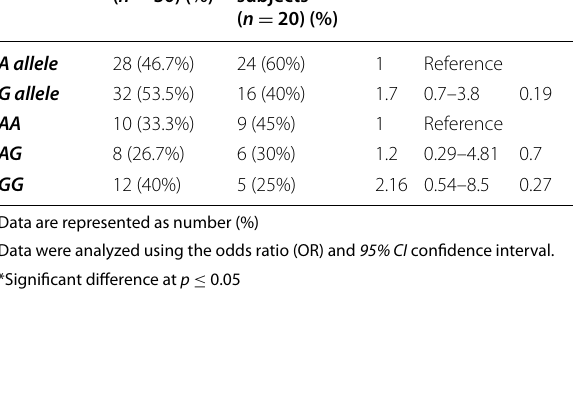
Table 3 Comparisons regarding the distribution frequencies of genotypes and alleles of the ESRα ( rs 9340799) between SLE patients and control subjects